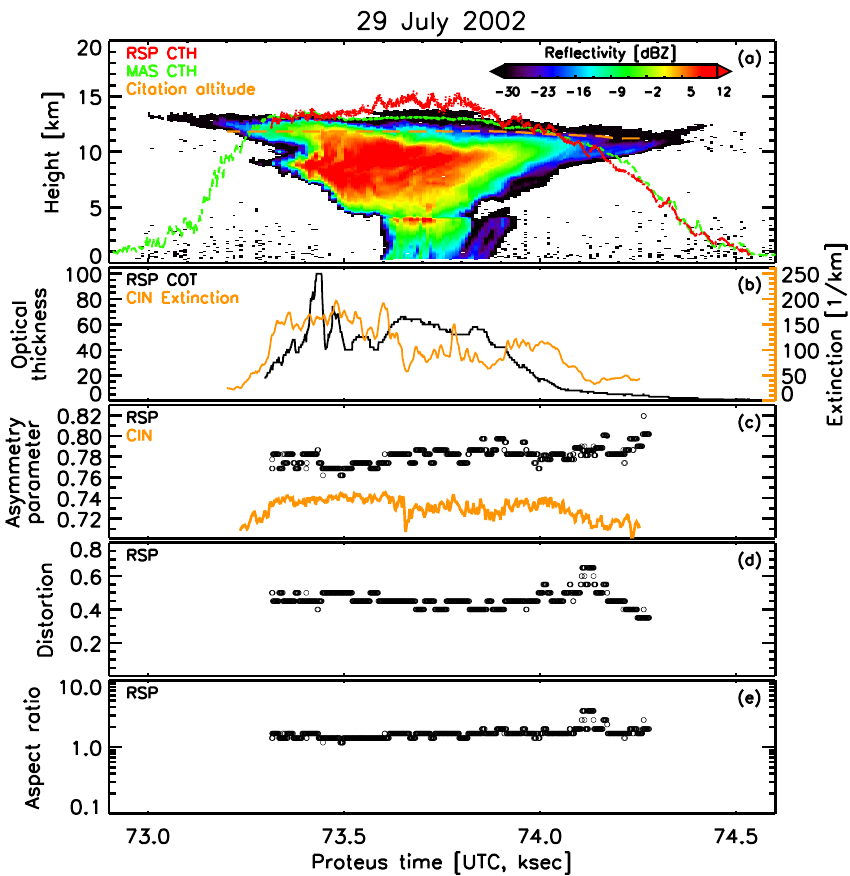
Fig. 3. RSP, CRS, MAS and CIN data for 29 July 2002 as a function of time corresponding to the RSP data on the Proteus aircraft. CRS, MAS and CIN data are shifted and stretched/squeezed in time to best collocate with the RSP data. (a) Cloud radar reflectivity (color contours); RSP retrieved cloud-top height (red) with minimum and maximum retrieved heights in dotted lines; cloud-top height derived from MAS 11µm brightness temperature (green) and altitude of Citation aircraft carrying CIN (orange dashed). (b) Cloud optical thickness (COT) retrieved by RSP (black, left axis) and extinction derived from CIN (orange, right axis). (c) Asymmetry parameter retrieved from RSP (black) and CIN (orange). (d) Distortion parameter from RSP. (e) Aspect ratio from